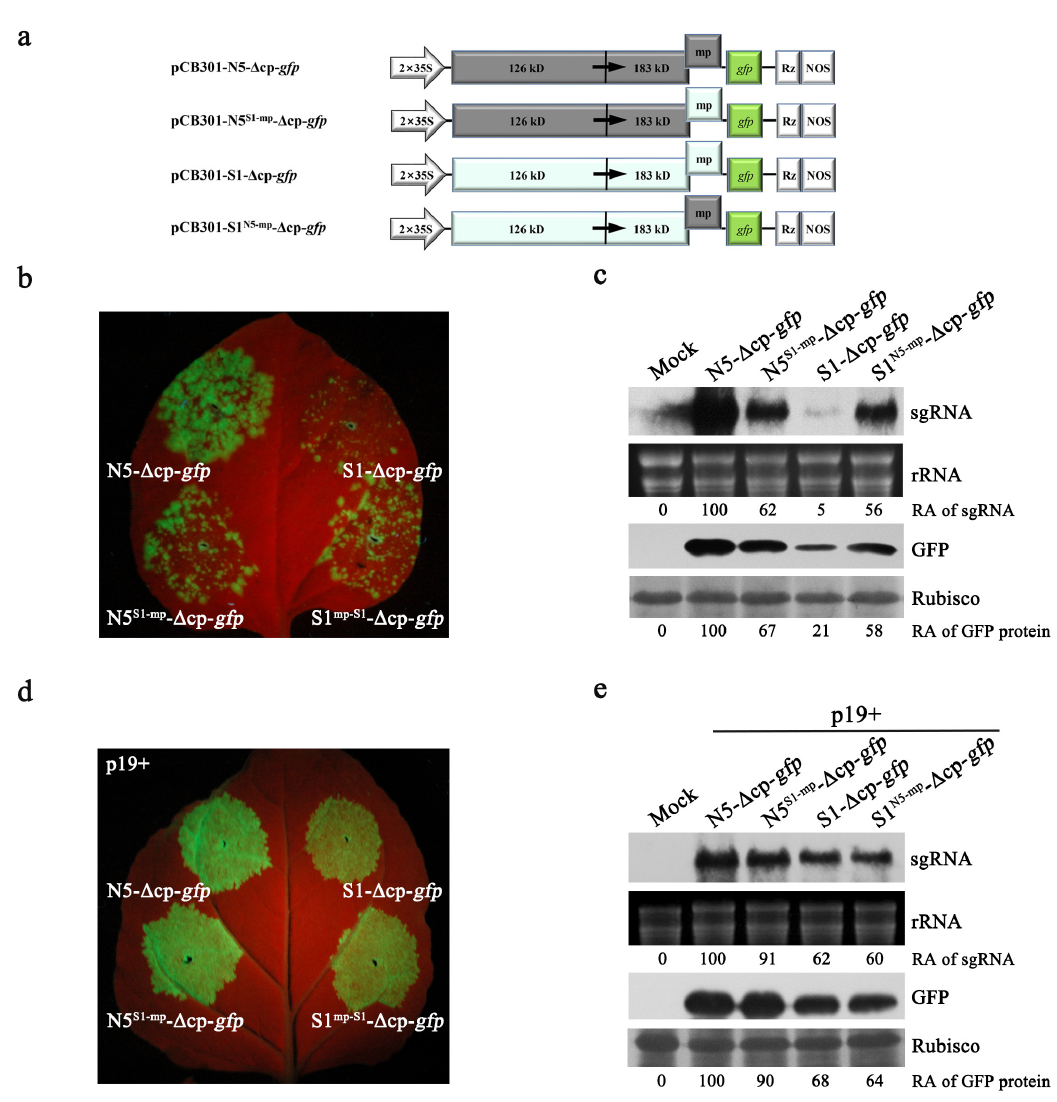
Figure 3. The difference in both N5 and S1 MPs-mediated viral accumulations was restored in the presence of the RNA silencing suppressor p19. ( a ) Schematic diagrams of N5- Δ cp- gfp , S1- Δ cp- gfp , and their MP exchangers, where the CP gene was deleted. ( b , d ) Green fluorescence appearance on the leaves of N . benthamiana inoculated with N5- Δ cp- gfp , S1- Δ cp- gfp , and their MP exchangers in the absence of p19, or in the presence of p19, respectively. GFP fluorescence was photographed at 4 dpi. ( c , e ) RNA blotting analyses of GFP-expressing subgenomic RNA (sgRNA) and Western blotting detection of GFP protein from the leaf samples as shown in ( b , d ), respectively. Relative accumulation levels of sgRNA and GFP protein are shown below. Ethidium bromide-stained ribosomal RNAs (rRNAs) and Ponceau S-stained Rubisco were used as loading controls for Northern blot and Western blot, respectively.